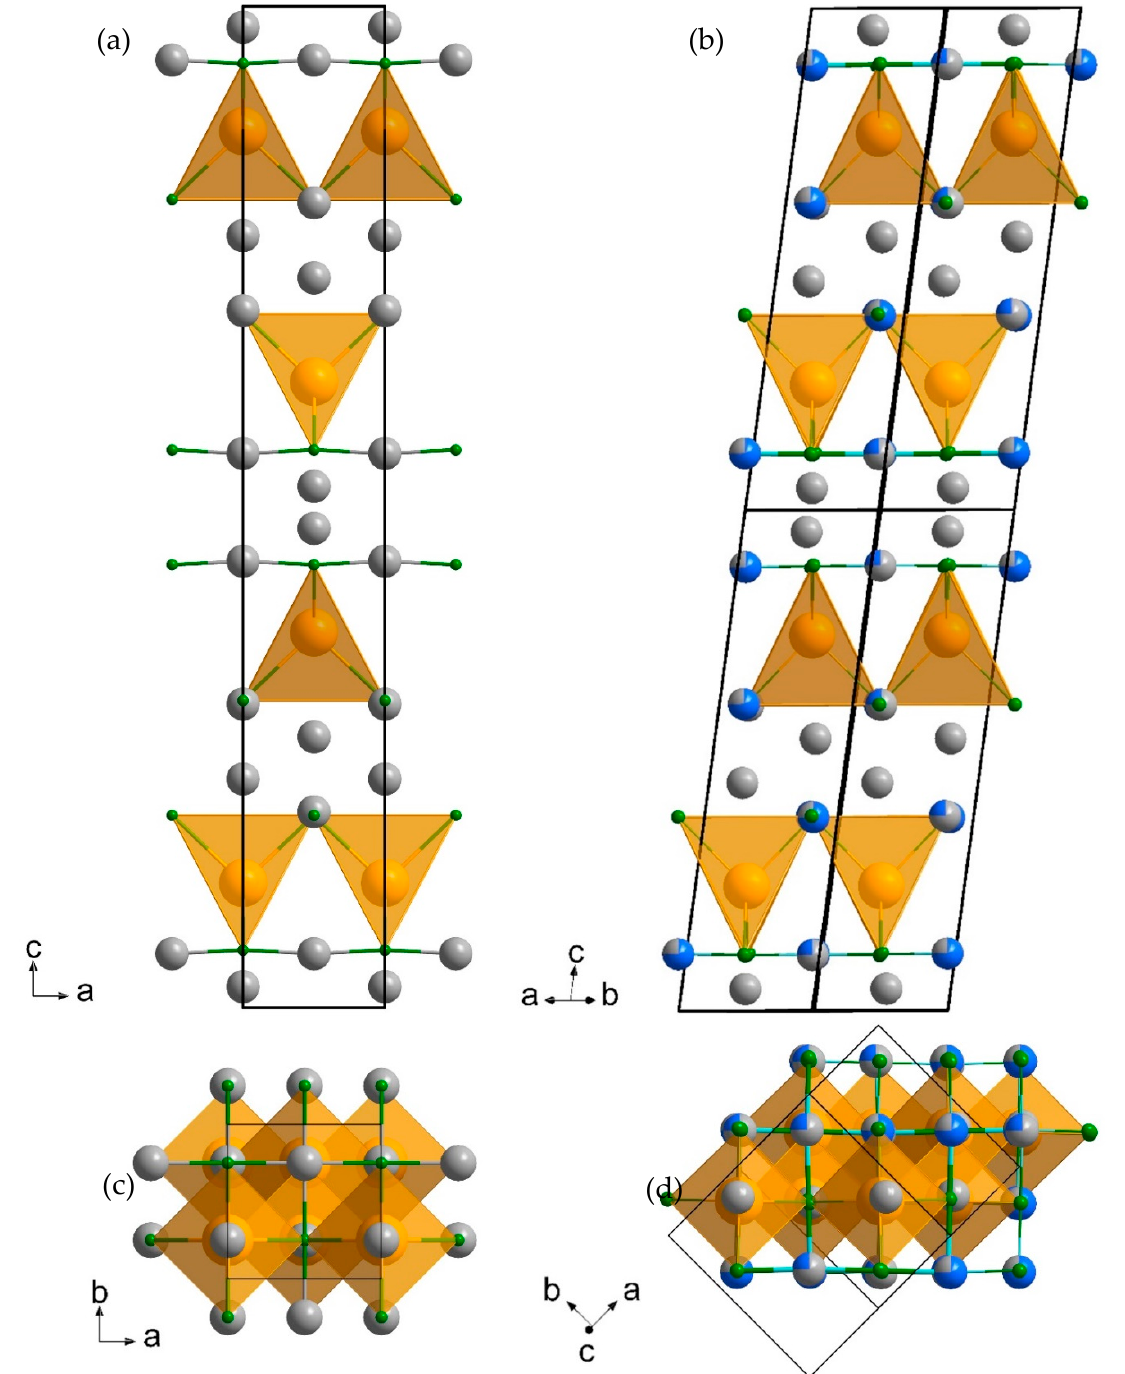
Figure 3. Crystal structure comparison of: ( a ) Li 4 SrN 2 (Sr–orange, N–green and Li–silver) [3]; ( b ) SrLi 2 {Li 0.65 Co 0.35 [Co 0.65 Li 0.35 N 2 ]} (Sr–orange, N–green, Li–silver and Co–blue); ( c ) Li 4 SrN 2 viewed along the c axis [3]; ( d ) SrLi 2 {Li[CoN 2 ]} viewed along the c axis. Unit cells are shown by black lines.